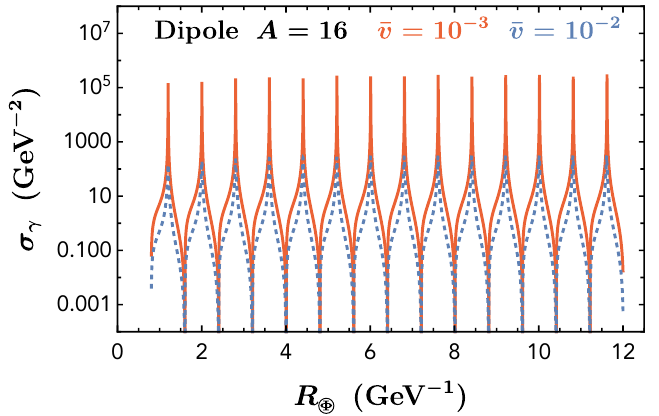
Figure 2 . Radiative capture cross section as a function of the DMB radius for the oxygen nucleus with Z = 8 and A = 16 in the dipole approximation. The dominant p -wave bound states and s -wave scattering states are included in this plot. Two di(cid:11)erent dark matter averaged velocities of (cid:22) v = 10 (cid:0) 3 and (cid:22) v = 10 (cid:0) 2 are